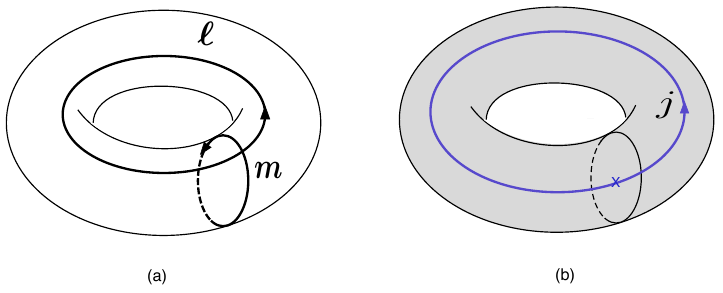
Figure 3 . (a) The meridian and longitude cycles on a torus T 2 . (b) The state a Wilson line in the representation j placed in the bulk of the solid